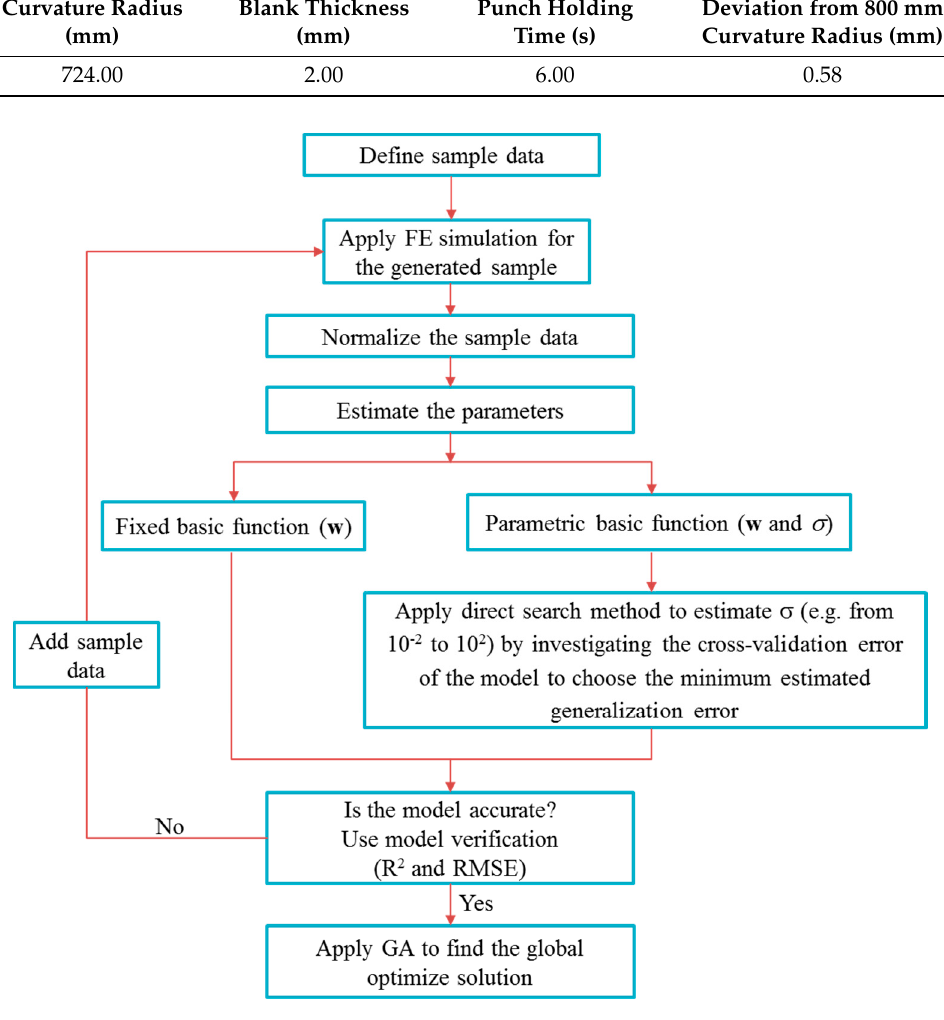
Figure 11. Radial basis optimization algorithm.